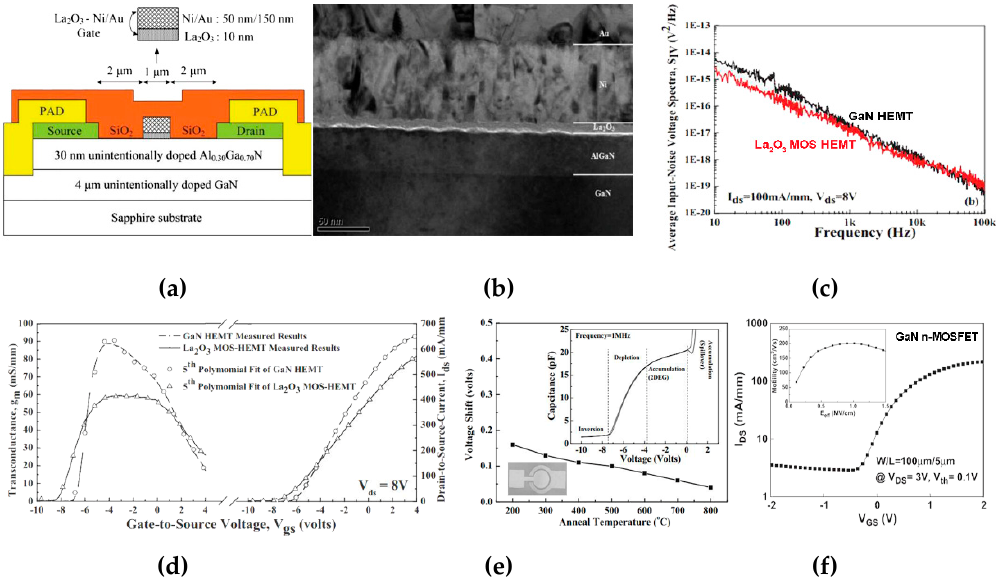
Figure 16. ( a,b ) Device structure and TEM image, ( d ) I–V, ( c ) noise, and ( e ) C-V and hysteresis voltage shift properties of La 2 O 3 AlGaN/GaN MOS-HEMT [146]. ( e ) I–V and mobility characteristics of GaN n-MOSFET [145].